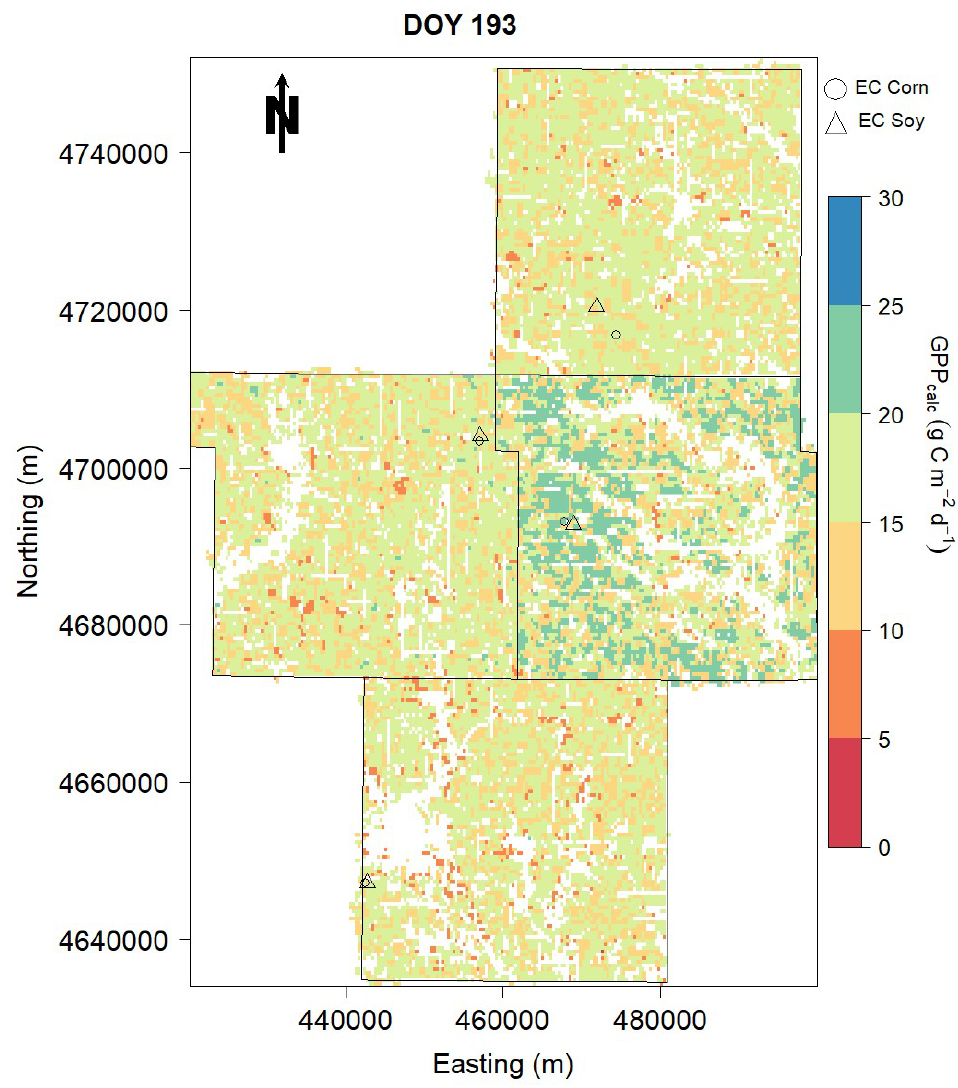
Figure 6. Daily GPP calc (g C m − 2 d − 1 ) on DOY 193 in 2016 for four Iowa counties. Triangles and circles show the location of the eddy covariance (EC) stations in soybean and corn fields, respectively.